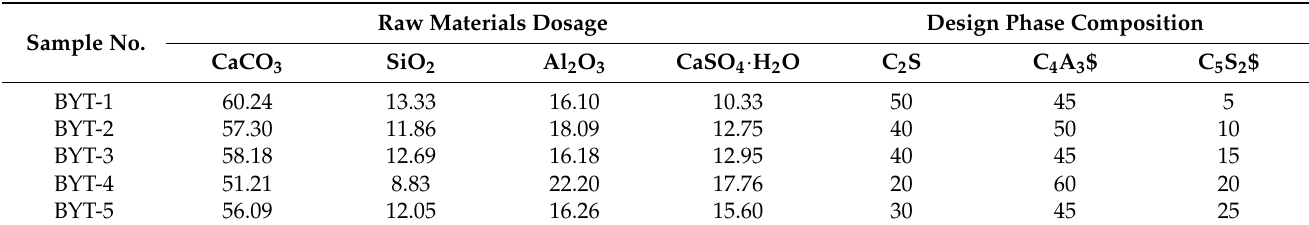
Table 1. Design phase composition of clinker and amount of raw materials